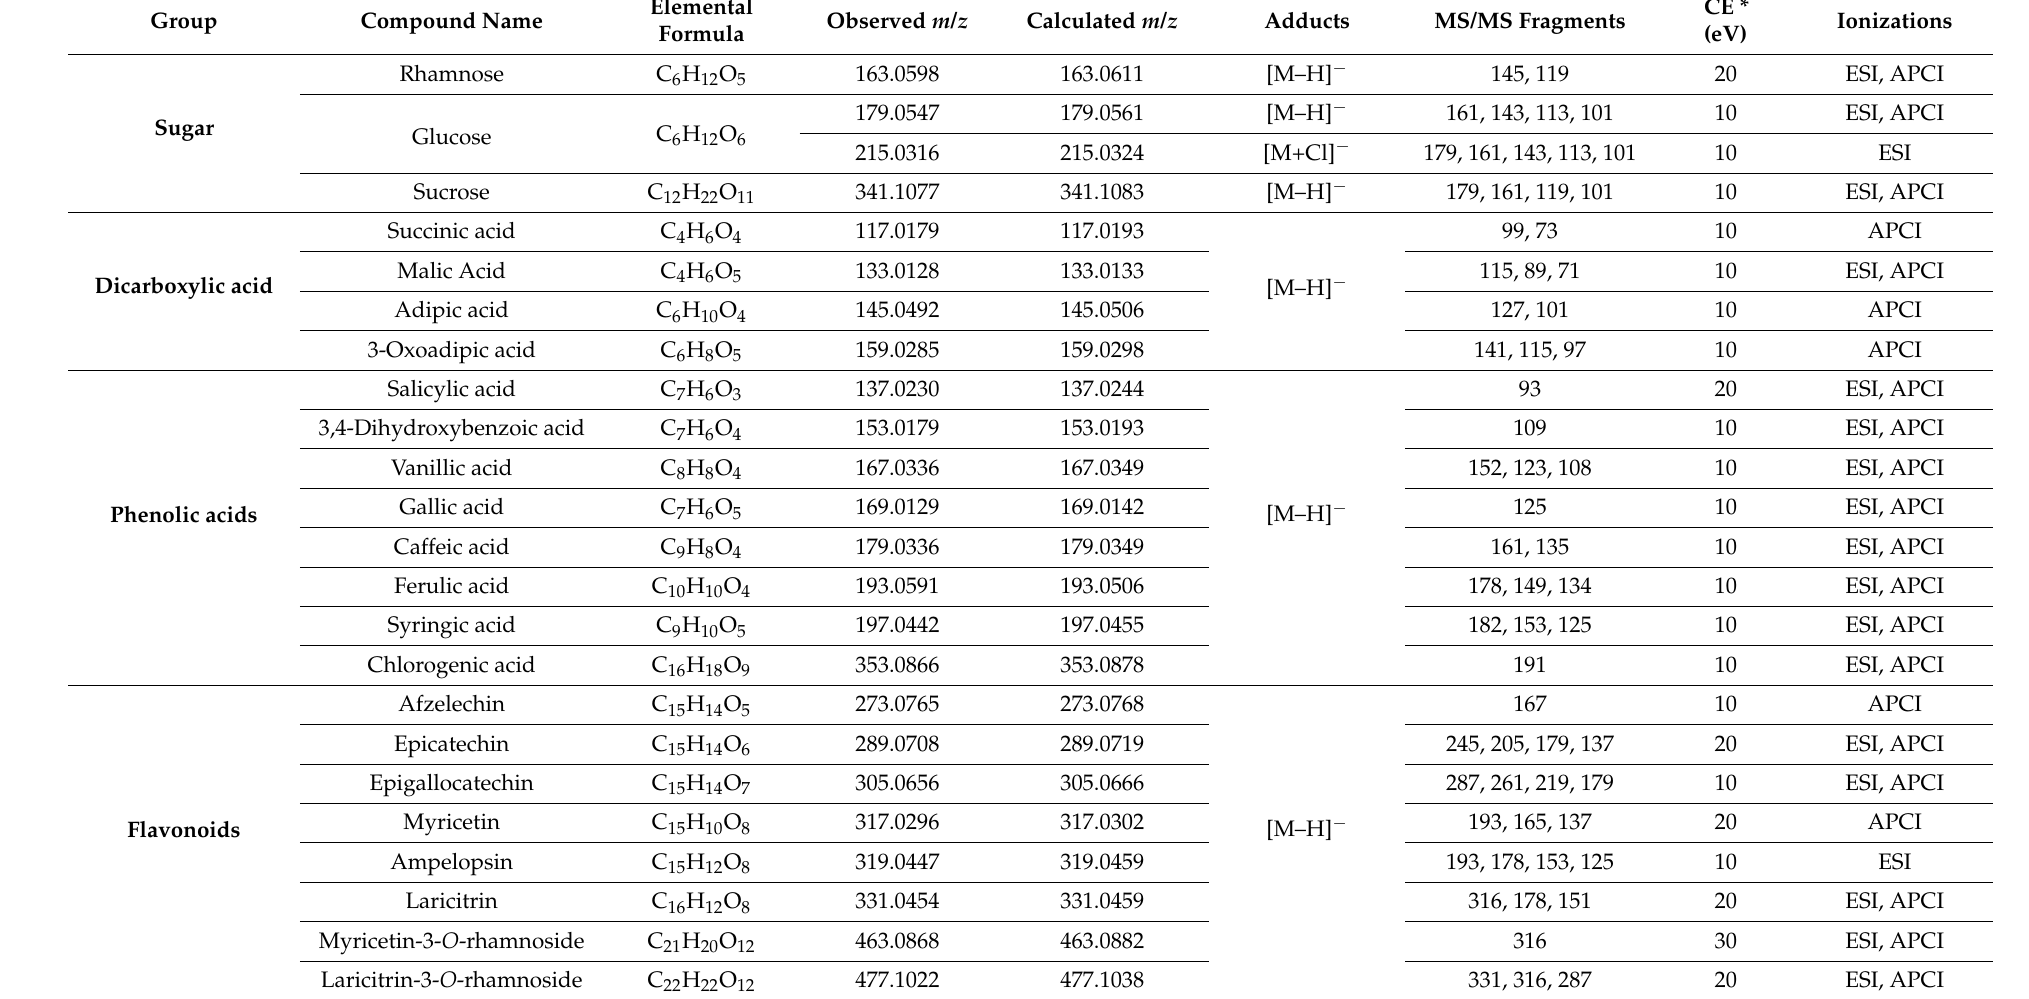
Table 1. Secondary metabolites identified in leaves of Manilkara zapota using negative-mode electrospray ionization mass spectrometry (ESI–MS) and atmospheric pressure chemical ionization mass spectrometry